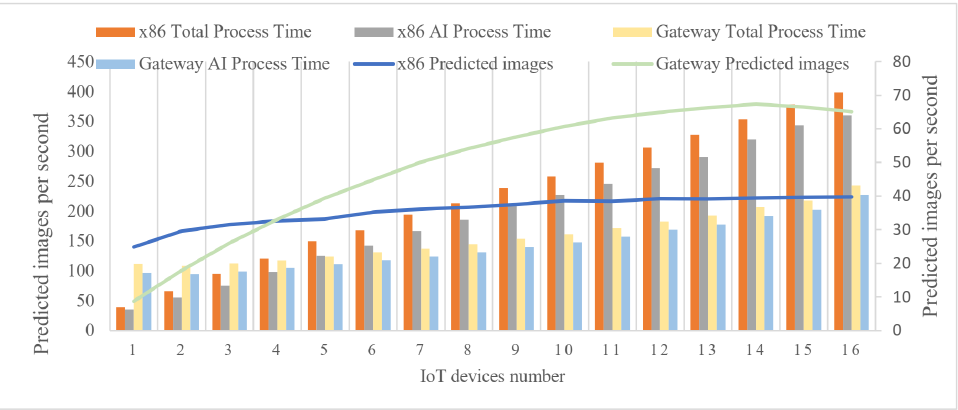
Figure 9. Performance comparison between x86 and the AIoT EC